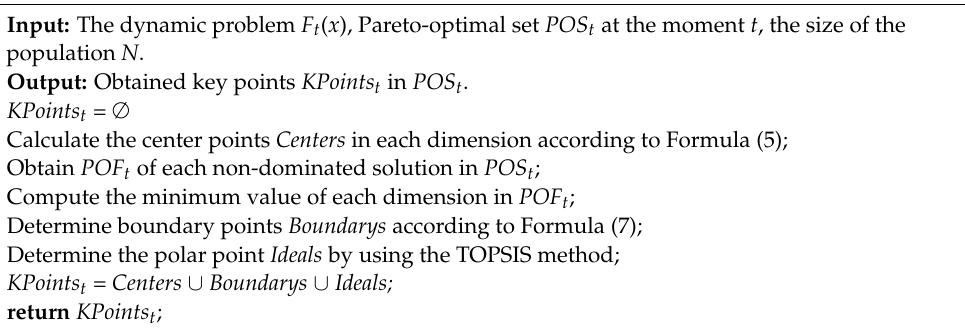
Algorithm 2: Determine key points (DKP)